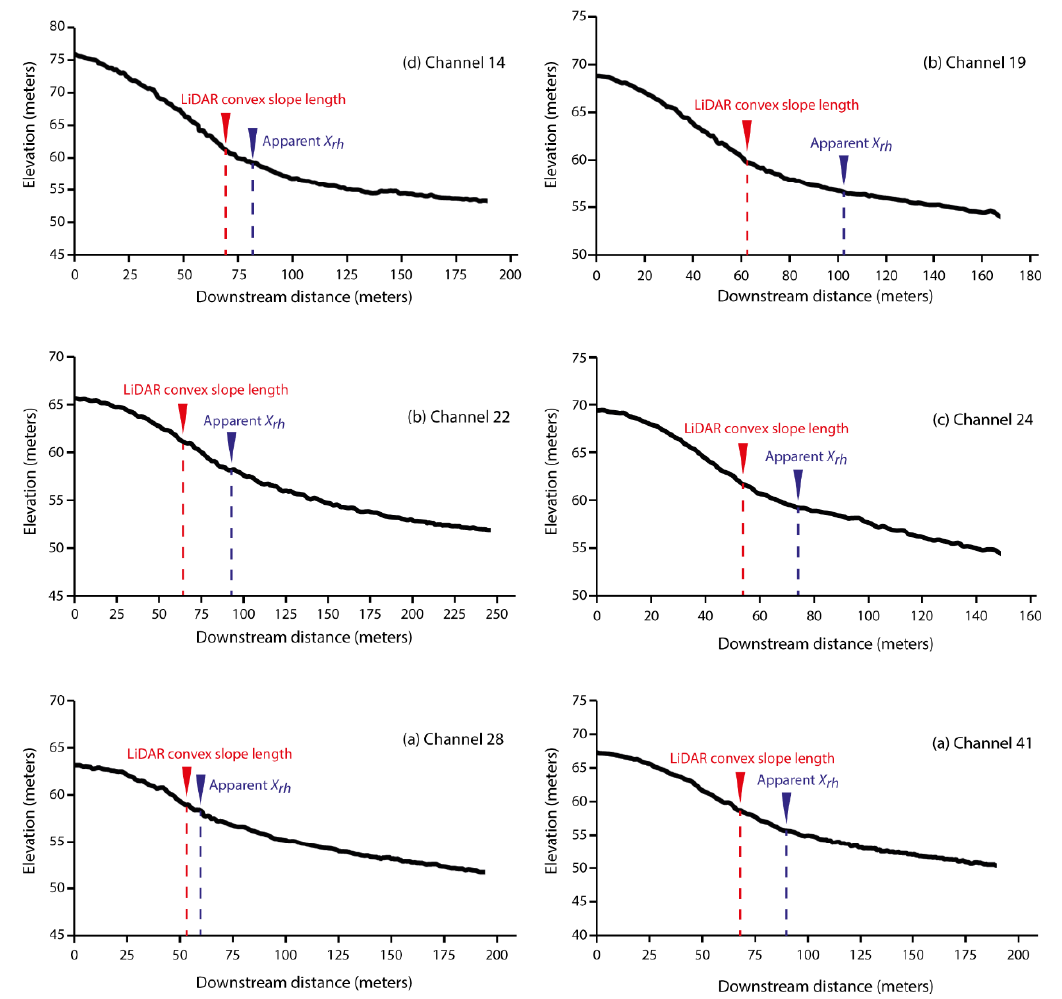
Figure 6. Graphical representation of the longitudinal slope profile for channels 14, 19, 22, 24, 28, and 41. The position on the channels’ slope profiles of the LiDAR (Laser Imaging Detection and Ranging) convex slope length and the apparent X rh is represented with a red and blue mark, respectively. In steady-state conditions, the value of both measurements should coincide. The difference, at the studied landscape, is due to the effect of ploughing, which buries part of the head of the channels. In some cases, as seen in channel 22, small local concavities or irregularities in the DEM (Digital Elevation Model) can lead to misinterpretations of the convex-to-concave inflection point of the channels’ profile. These anomalies should decrease as the precision and point density of the LiDAR data increases.